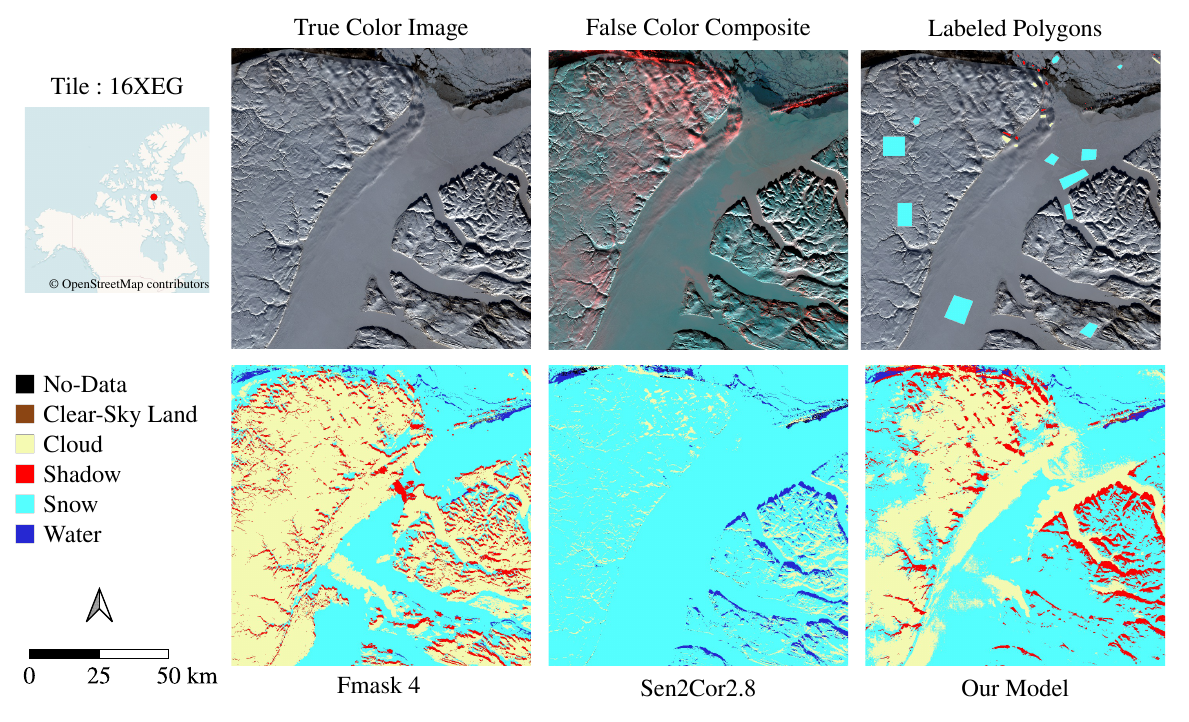
Figure A2. Comparison of validation image results from Tile 16XEG in Nunavut, Canada, captured